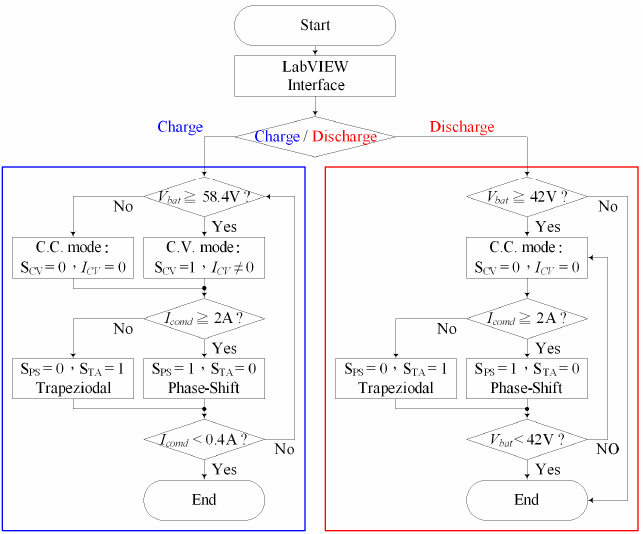
Figure 7. The flowchart of the proposed control scheme.